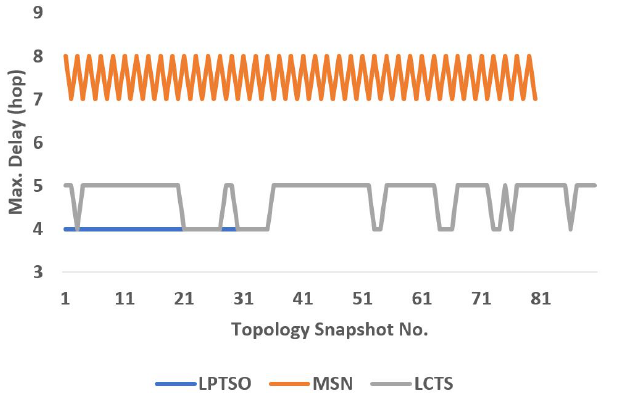
Figure 12. Maximum delay with three different methods.